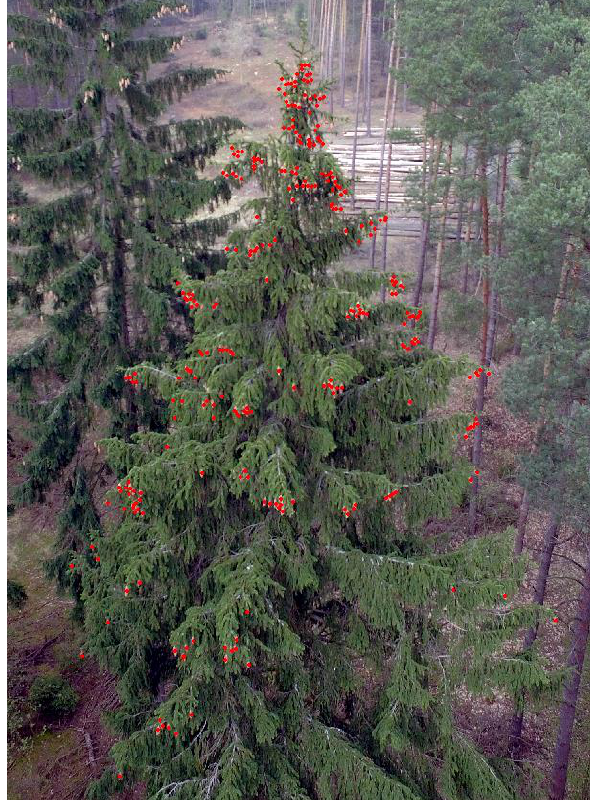
Figure 4. An example of diagonal image (red dots symbolize counted cones).